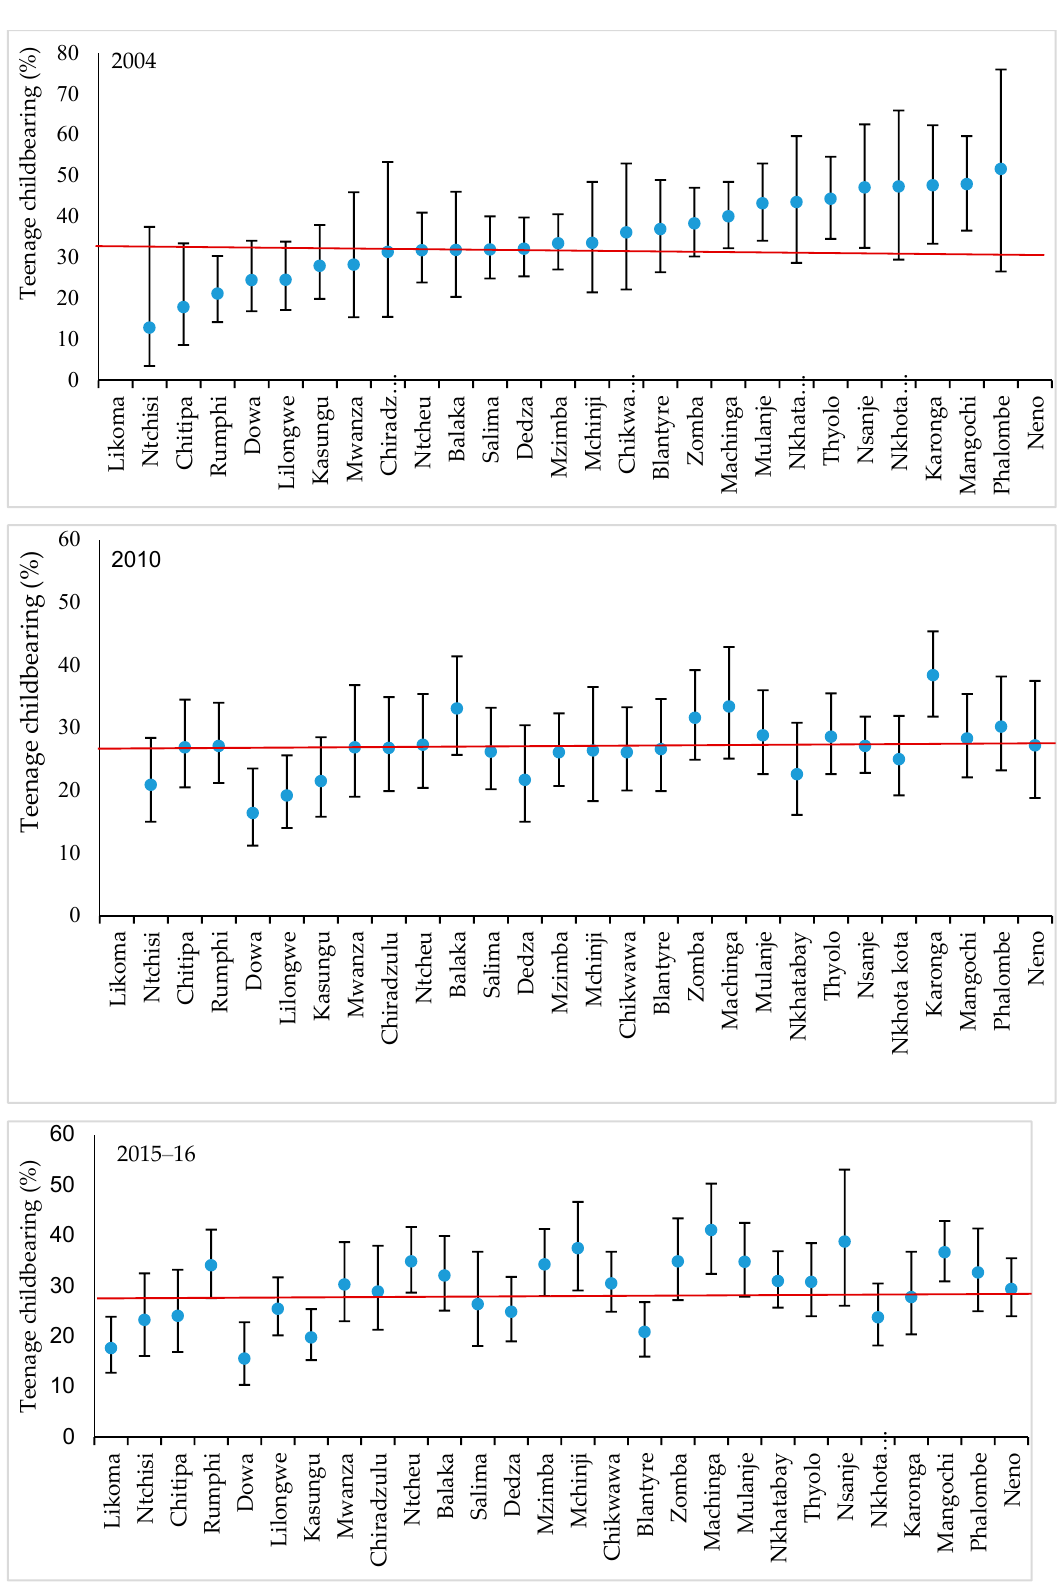
Figure 1. Prevalence of teenage childbearing by district from 2004 to 2015–16 MDHS.